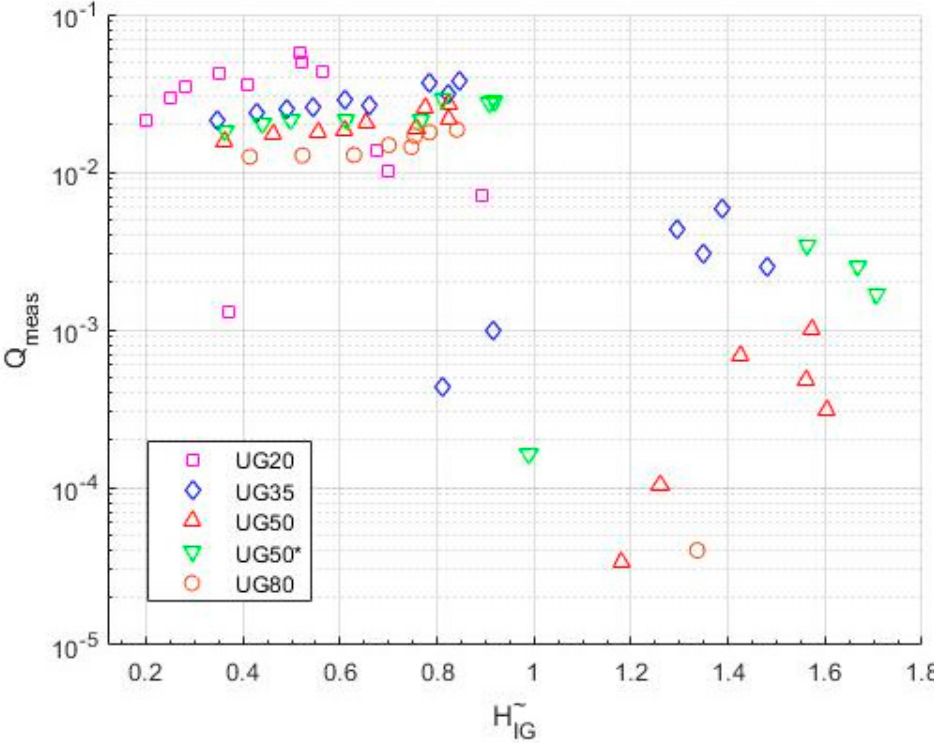
Figure 5. Variation in the dimensionless overtopping discharge versus the ratio of IG wave height to SS wave height at the toe of the structure.